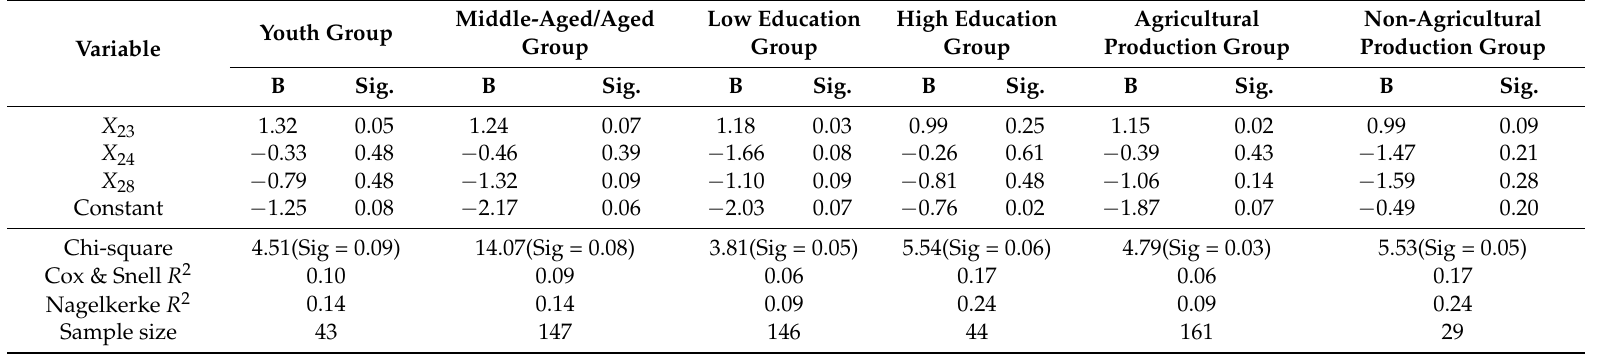
Table 4. Cluster analysis results of migration willingness of farmers classified according to individual